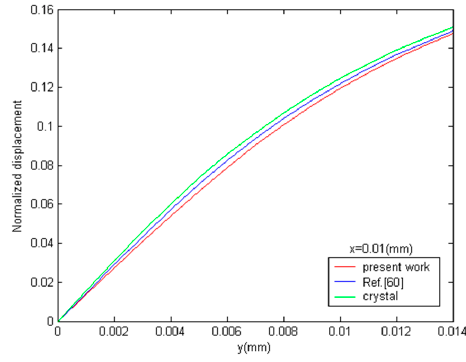
(cid:107) with y ( x = 0.01mm). Figure 3. Variations of 3